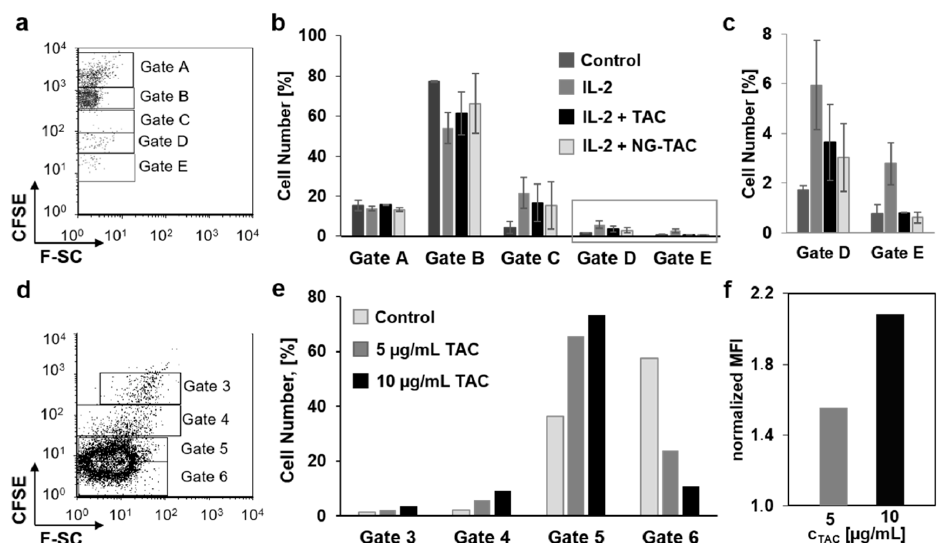
Figure 4. E ff ects of tacrolimus in solution or formulated in nanogels on Jurkat and T-cell Figure 4. Effects of tacrolimus in solution or formulated in nanogels on Jurkat and T-cell proliferation